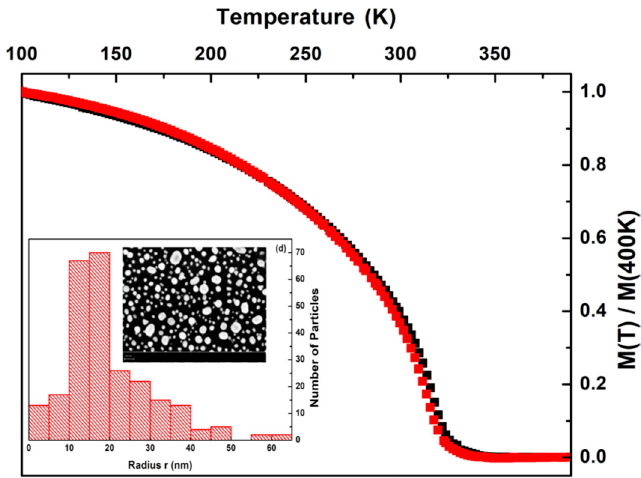
Figure 7. Temperature dependence of the normalized magnetization, M(T)/M(400 K) of a 12 u.c. thick LSMO/STO(100) film before (black) and after (red) deposition of Au-nanoparticles (Au-NPs). The inset shows particle size distribution calculated over the shown secondary electron microscopy image. “Reprinted figure from [32]. Licensed under the Creative Commons Attribution 4.0